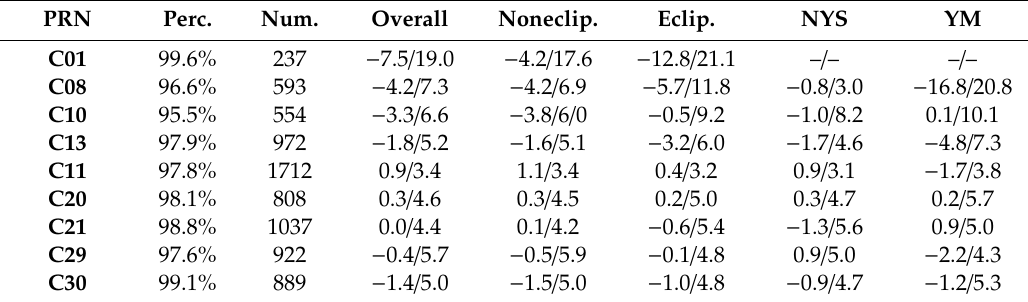
Table 3. The statistical information of the percentage of the available SLR observations, the number of the available SLR observations, and the Mean / RMS for SLR validation residuals (Unit: cm).